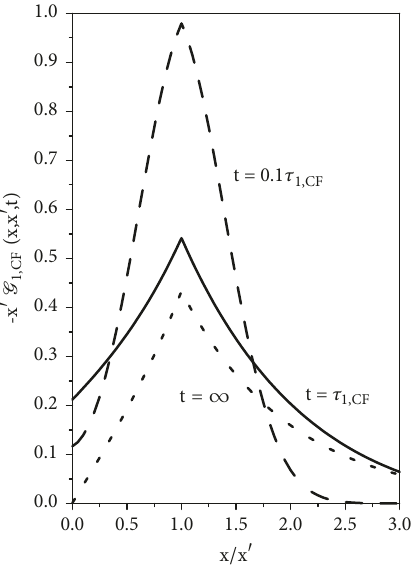
Figure 4: This figure illustrates the behavior of (29) by considering different times. We consider, for simplicity, 𝜏 1,𝐶𝐹 = √𝑥 󸀠2 /𝐷 1 , /𝑥 󸀠 = 1 , and 𝛼 𝜏 = 1/2 , in arbitrary unities. 𝑘𝜏 1,𝐶𝐹 1 1,𝐶𝐹